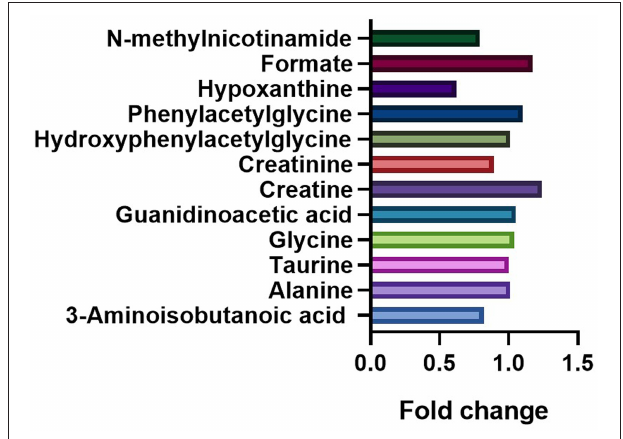
TABLE 1 | Pearson’s correlation coefficient of discriminant metabolites. Metabolites